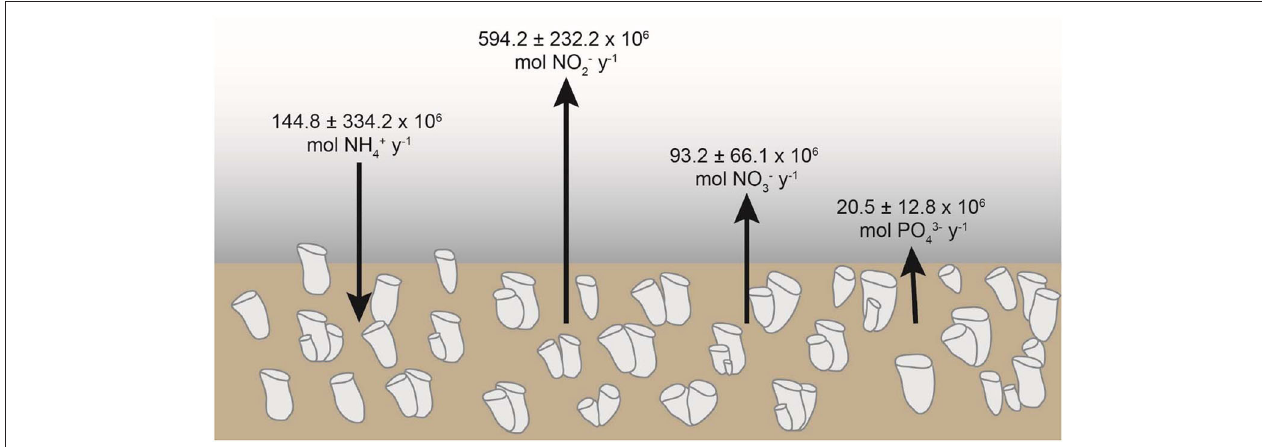
FIGURE 11 | Summary of the annual net flux of ammonium (NH + 4 ), nitrite (NO − 2 ), nitrate (NO − 3 ), and phosphate (PO 3 − 4 ) across the aggregations of Vazella pourtalesii at the Scotian Shelf (Canada). Another interesting feature is that most individuals of